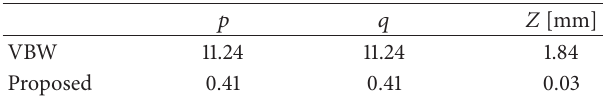
Figure 6: Sphere image. Table 1: Mean error.